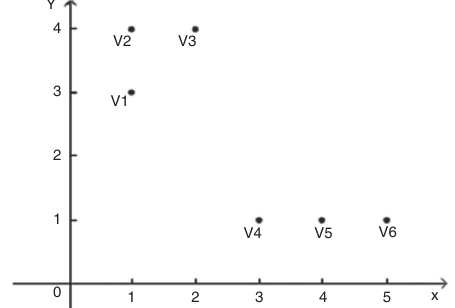
Figure 2. Data before clustering